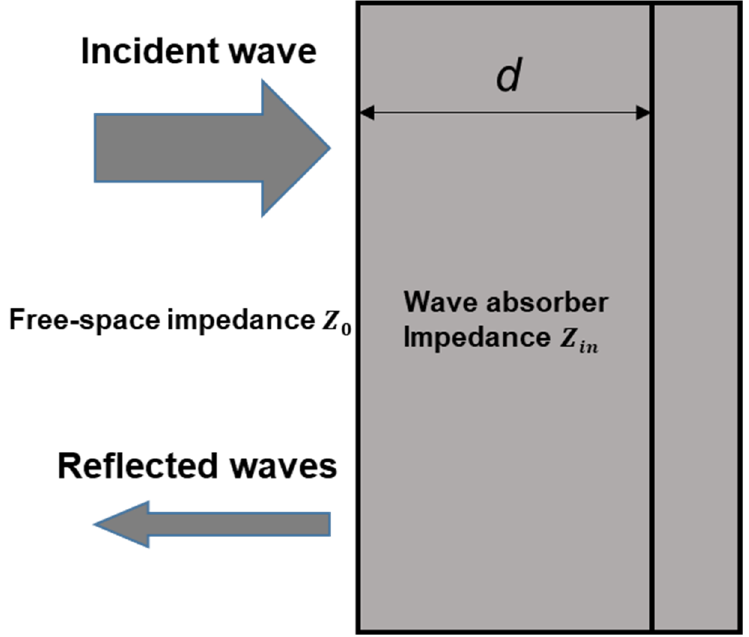
Figure 1. Schematic diagram of electromagnetic wave incident on the absorbent surface.